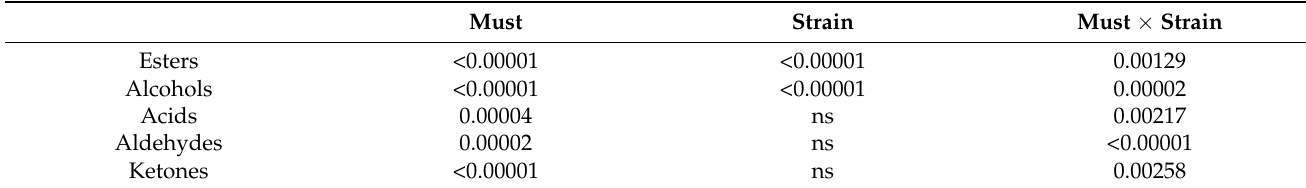
Table 1. Significance ( p -level) of the categorical predictors and their interaction on the total amounts of esters, alcohols, acids, aldehydes, and ketones produced by S. cerevisiae AWRI796 and EC1118 throughout the fermentation of five red grape musts; ns, not significant ( p > 0.05). Must Strain